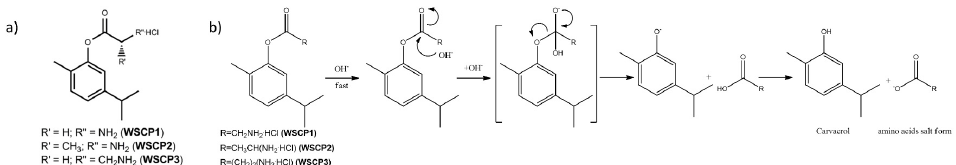
Figure 1. ( a ) Chemical structures of water soluble carvacrol prodrugs (WSCP1-3) and ( b ) proposed bioactivation of WSCP1-3 under alkaline conditions.